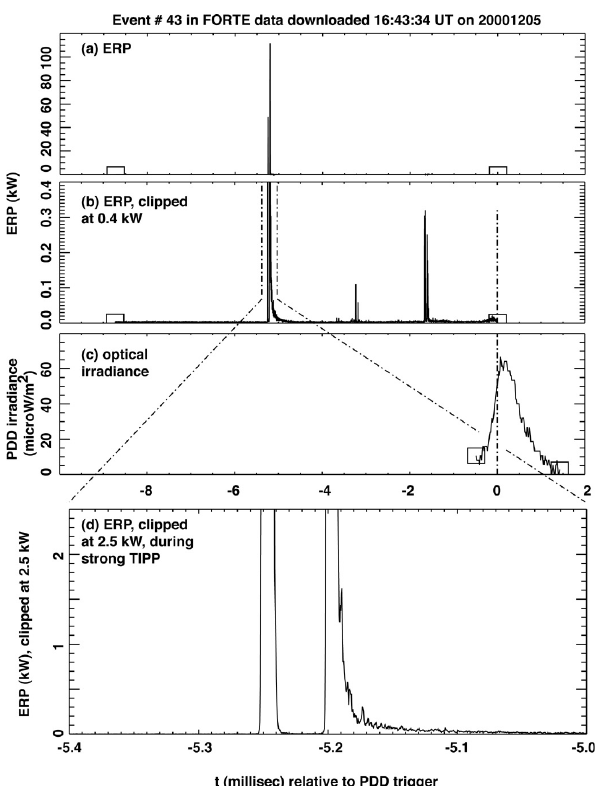
Fig. 4. First of the six HUMR–PDD events of Table 4. (a) ERP vs. time. Square symbols mark the start and stop of the record. Time is referenced to 0 at the PDD trigger time. (b) ERP vs. time, clipped at 0.4kW on the ordinate. (c) Optical irradiance vs. time, with the trigger time marked by a vertical dashed line. (d) ERP vs. time, clipped at 2.5kW on the ordinate, and restricted to the zoom limits marked in panel (b) .